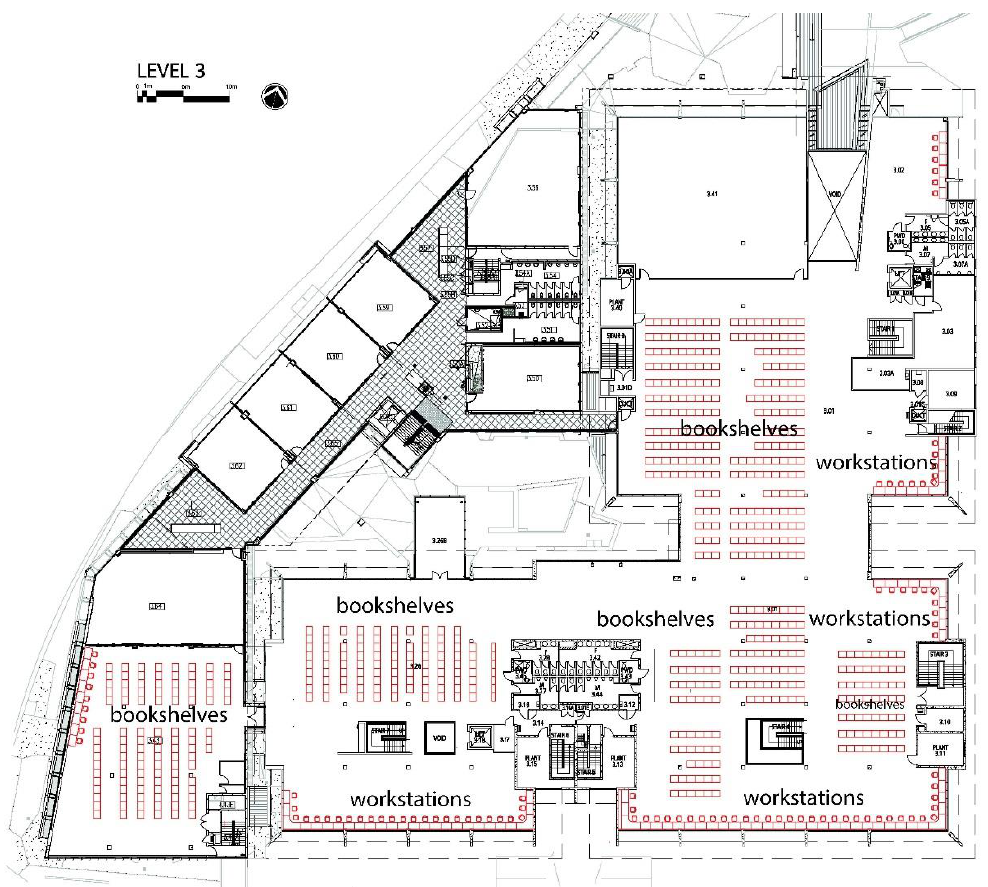
Figure 2. The floor plan of Level 3; 88 workstations which are located next to windows and face the outside are selected for this study.